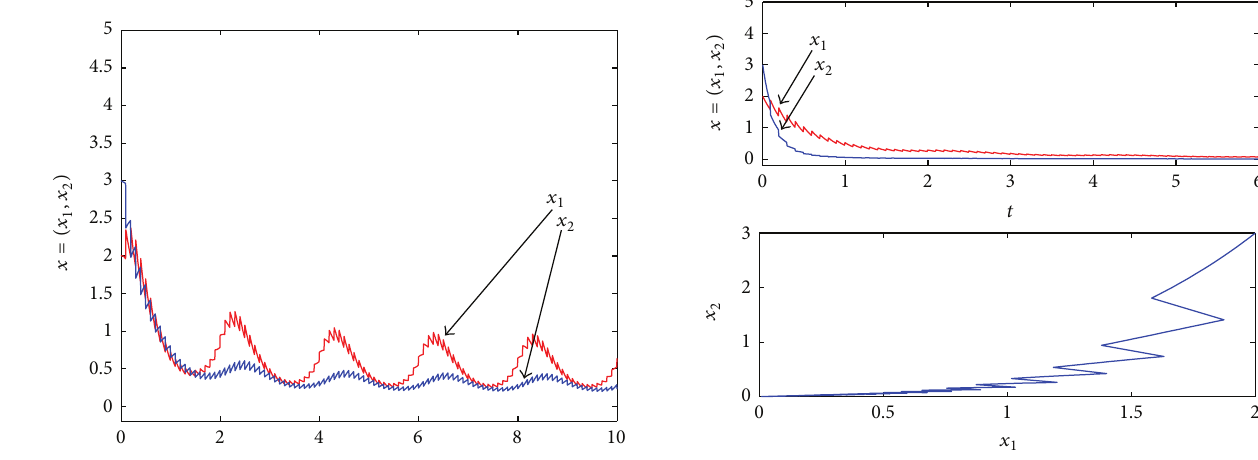
Figure 4: The time series of the permanence of species x .